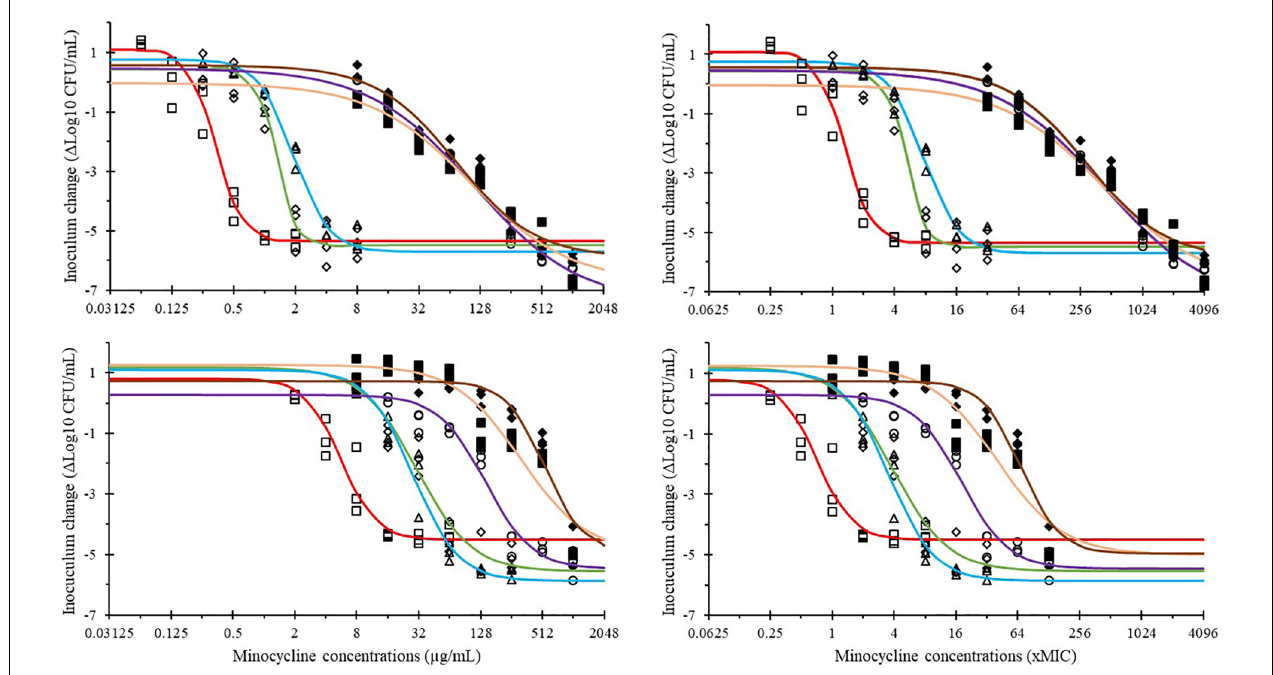
FIGURE 3 | Modeling of the mean inoculum change ( (cid:49) Log10 CFU/mL) in function of minocycline concentrations expressed in µ g/mL (left) and MIC fold (right) in different media for two E. coli strains ATCC25922 (top) and 2S1F2 (bottom); media were MHB ( ), SIC jejunum ( ), SIC ileum ( ), SIC cecum ( ), SIC colon ( ), and SIC feces ( ). TABLE 3 | Mean ± SD pharmacodynamic parameters calculated with Equation 1 (sigmoid E max model), describing killing effects of minocycline on ATCC25922 in different matrices (mueller hinton broth (MHB) and sterilized intestinal contents (SIC), from jejunum, ileum, cecum, colon, and feces). Medium